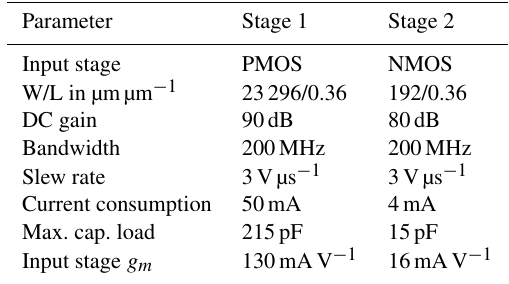
Table 1. OTA performance